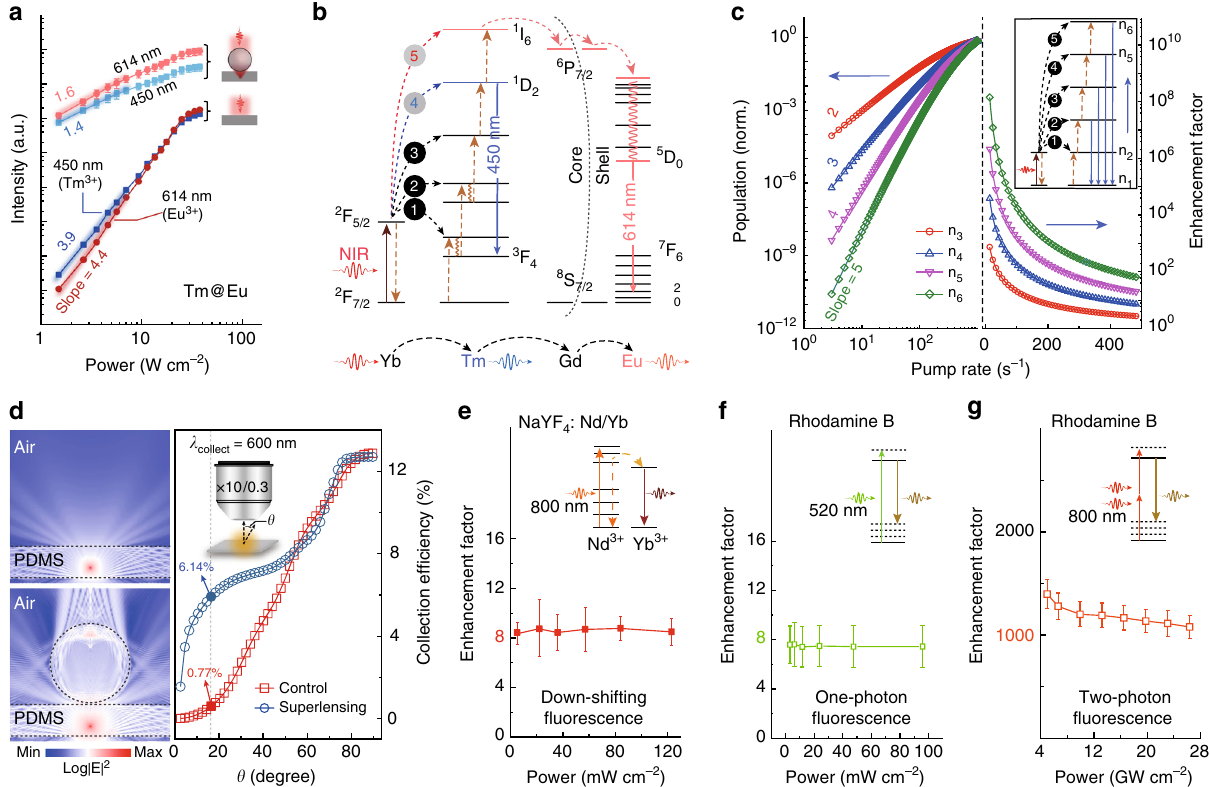
Fig. 3 Mechanistic investigations of dielectric superlensing-mediated upconversion ampli fi cation. a Upconversion fl uorescence power-dependent studies of luminescence enhancement in the NaGdF 4 :Yb/Tm@NaGdF 4 :Eu-embedded PDMS substrate, recorded with and without microbead coverage. Error bars represent ± 1 s.d. b Proposed energy transfer diagrams showing the multistep excited state pumping of NaGdF 4 :Yb/Tm@NaGdF 4 :Eu UCNPs. The emission of Eu 3 + is generated by accepting the down-shifting energy from Gd 3 + sublattice. c Numerical simulation results based on a simpli fi ed energy transfer model involving two-to- fi ve-photon upconversion processes. It is clear to fi nd that upconversion emission from higher excited states is more sensitive to the excitation pumping rate. Besides, the luminescence enhancement dominates with higher-order upconversion emission. d Comparative simulations of the far- fi eld emission collection ef fi ciency for upconversion enhancement, obtained in the presence or absence of a dielectric microbead. e Down-shifting luminescence enhancement of Nd/Yb codoped NaYF 4 nanocrystals using dielectric microbeads. (Inset) The proposed energy transfer mechanism for NaYF 4 :Nd/Yb down-shifting nanocrystals. Error bars represent ± 1 s.d. f , g Microbead-mediated enhancement recorded for linear and two-photon absorption luminescence from Rhodamine B dye molecules. (Insets) The corresponding Stokes emission and two-photon absorption-emission mechanisms, respectively. Error bars represent ± 1